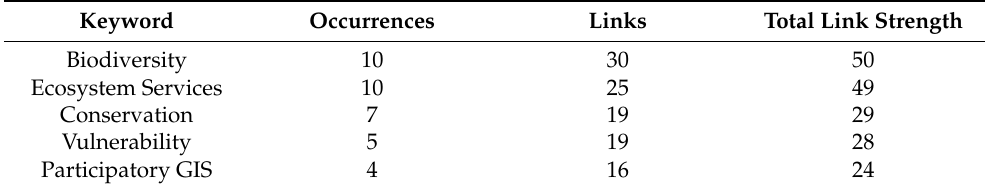
Figure 4. Co-occurrence network map of keywords from quantitative ES assessments for southern Africa published from 1991 to 2021. Table 3. Top 5 keywords on the co-occurrence network map of ESs based on total link